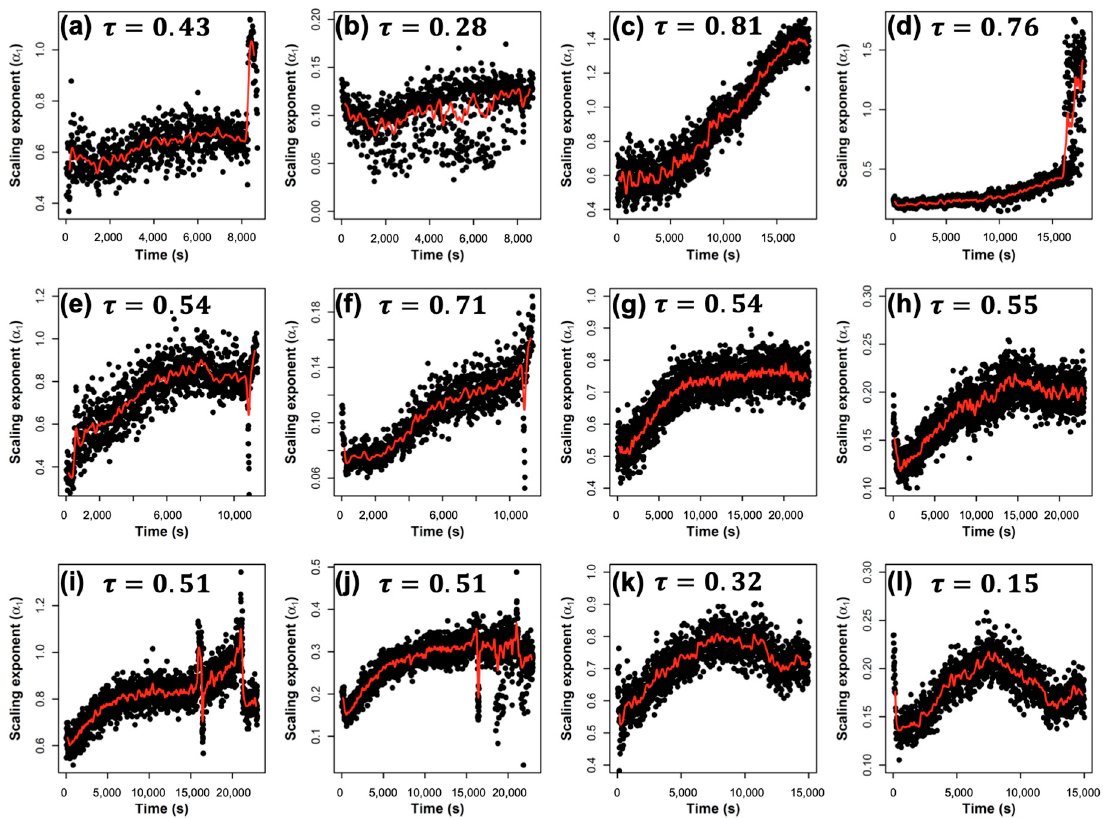
Figure 8. The scaling exponents ( α 1 ) of non-overlapping 2560-sample segments of the vibration signals toward bearing failure: ( a ) data set 1_2 (horizontal); ( b ) data set 1_2 (vertical); ( c ) data set 1_3 (horizontal); ( d ) data set 1_3 (vertical); ( e ) data set 1_4 (horizontal); ( f ) data set 1_4 (vertical); ( g ) data set 1_5 (horizontal); ( h ) data set 1_5 (vertical); ( i ) data set 1_6 (horizontal); ( j ) data set 1_6 (vertical); ( k ) data set 1_7 (horizontal); ( l ) data set 1_7 (vertical).